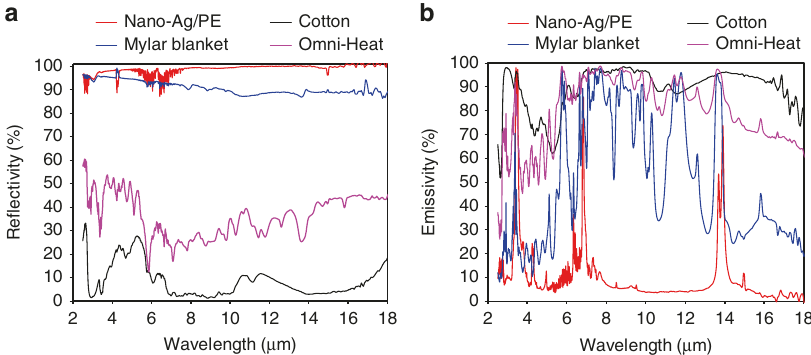
Fig. 2 Infrared property characterizations. a Measured total FTIR re fl ectance of the metallic coating side of nano-Ag/PE, cotton, Mylar blanket and Omni- Heat. b Measured total FTIR emittance at the textile outer surface of nano-Ag/PE, cotton, Mylar blanket and Omni-Heat